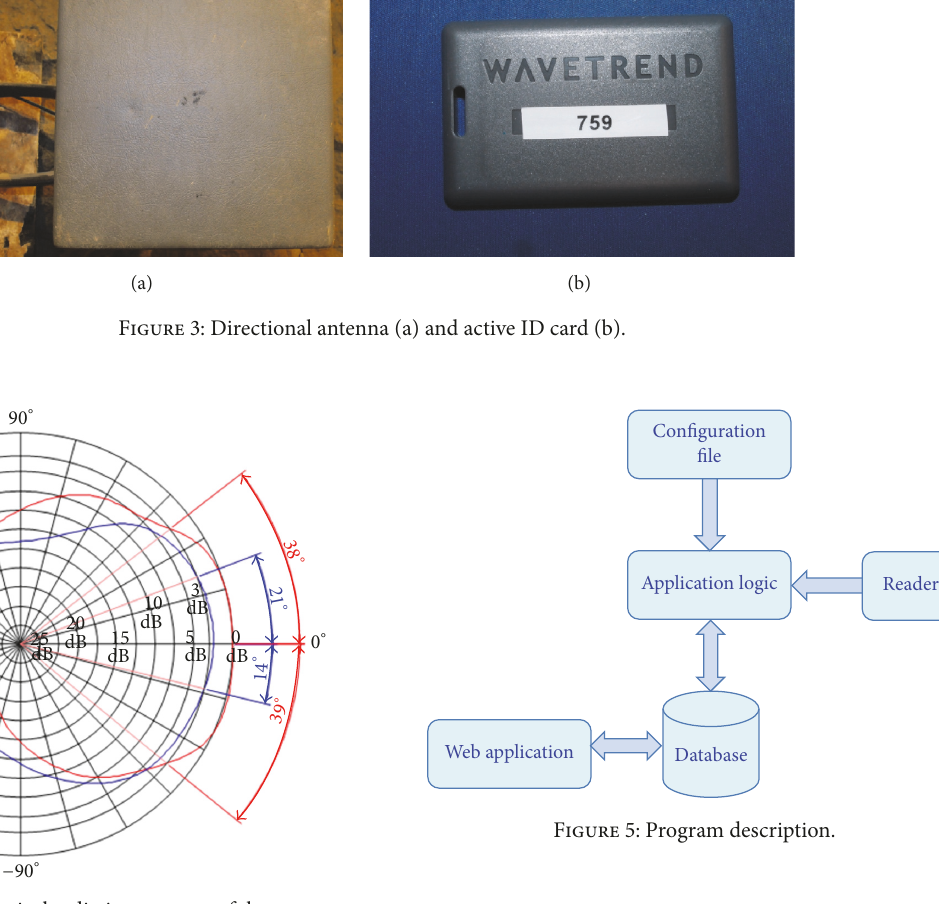
Figure 4: Horizontal and vertical radiation patterns of the antenna. The − 3dB ring is marked with the opening angles of both measure- ments.